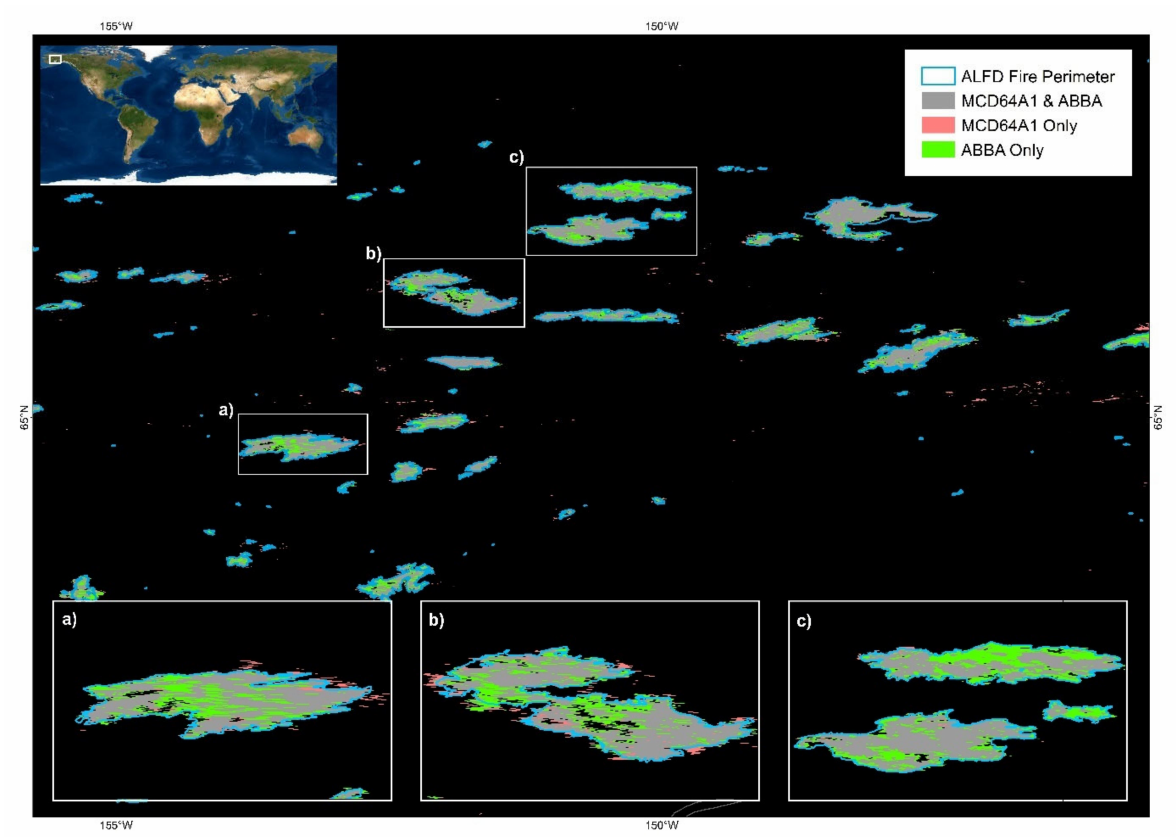
Figure 9. Close-up views of the differences in burned areas mapped by MCD64A1 and ABBA in Alaska in 2005. The ALFD fire perimeters are superimposed on top. Areas in gray indicate burned areas that are mapped by both MCD64A1 and ABBA. Areas in red and green indicate burned areas that are mapped only by MCD64A1 and only by ABBA,